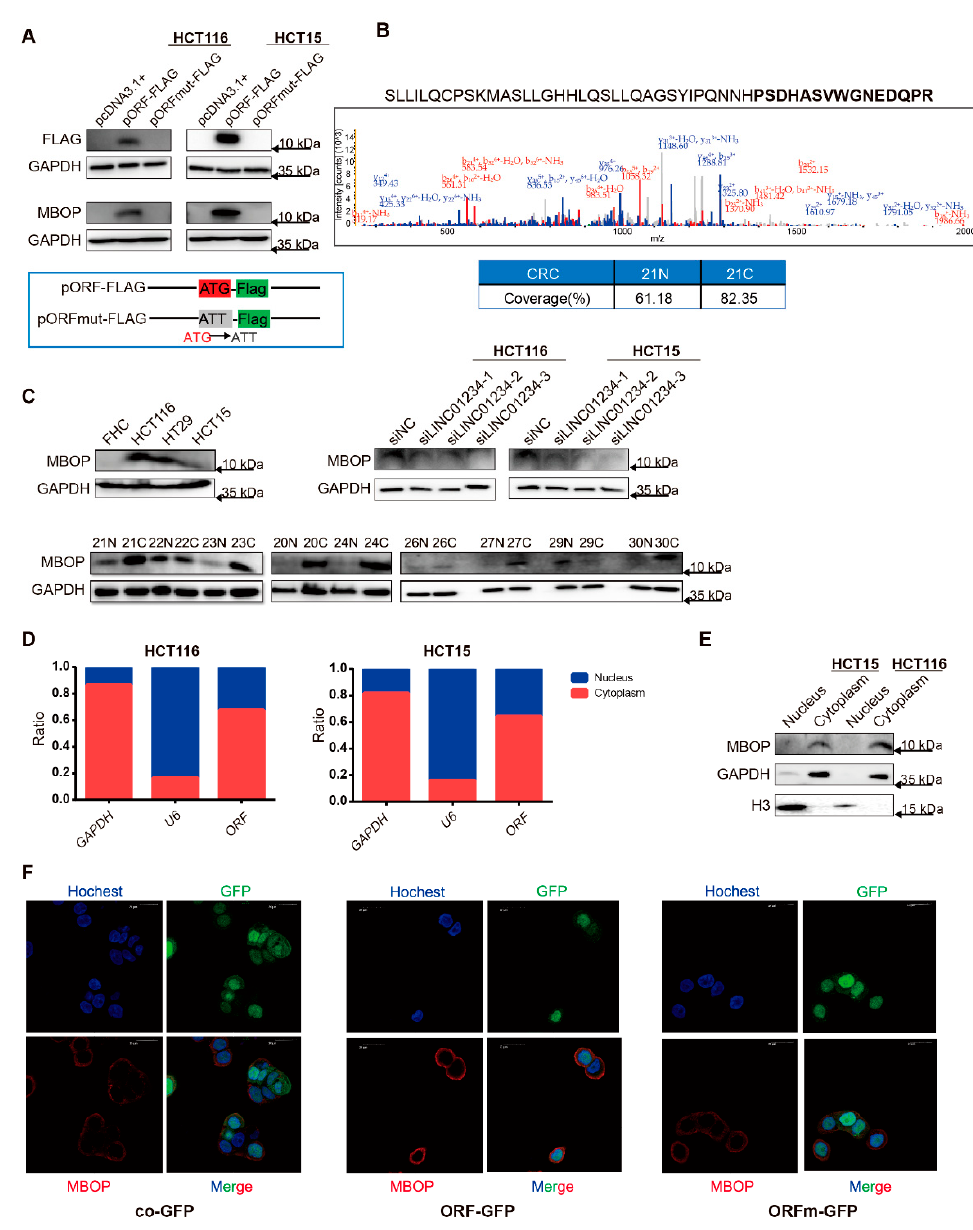
Figure 2. LINC01234 encodes an endogenous peptide highly expressed in CRC. ( A ) A group of three plasmids, pcDNA3.1+, LINC01234ORF-FLAG (pORF-FLAG), and LINC01234ORFmut-FLAG (pORFmut-FLAG) (upper panel) was prepared to verify the coding potential of LINC01234ORF, and the corresponding antibody for MBOP was validated (lower panel). ( B ) Based on an amino acid mass spectrometry analysis, MBOP was a naturally existing peptide, and the part in bold was applied for the generation of an antibody of MBOP (upper panel) and a pair of CRC tissues exhibited higher sequence coverage in the cancerous one than in the noncancerous one. ( C ) Expression of MBOP in CRC cell lines and tissues, and siRNAs targeting LINC01234 decreased the expression of MBOP. Note: The same siRNA-treated HCT116 samples from Figure 2C were used to detect the